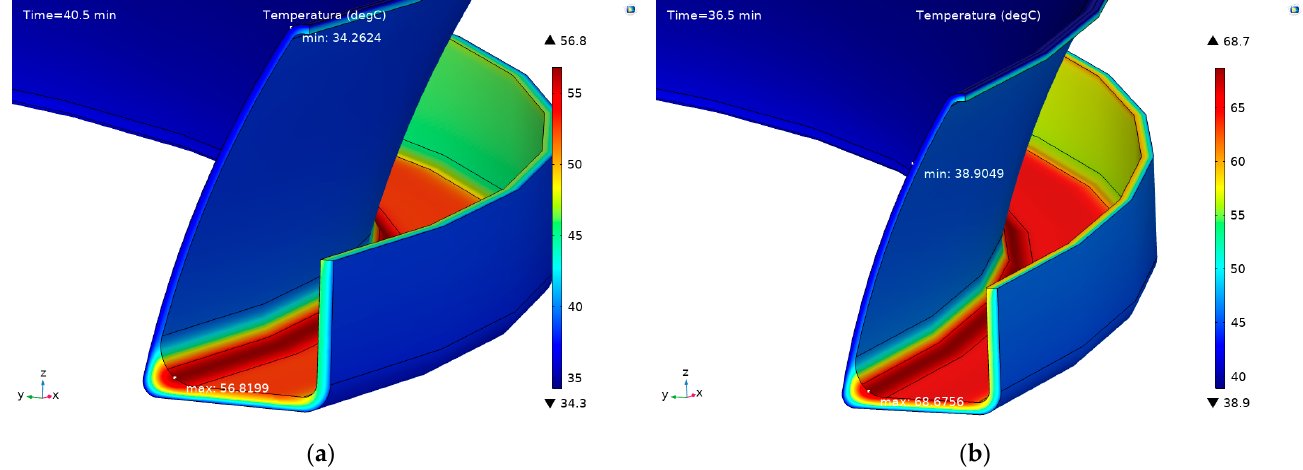
Figure 13. Temperature distribution within the part at the time when ∆ T is maximum for the cure at 60 °C ( a ) and 100 °C ( b ).